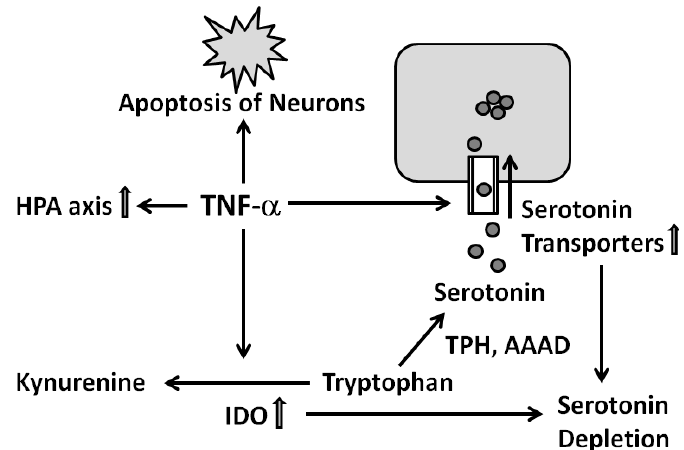
Figure 5. Mechanisms through which TNF- α could contribute to the emergence of a depression: activation of the hypothalamus-pituitary-adrenal (HPA) axis, induction of apoptosis, stimulation of the serotonin reuptake and induction of the IDO. For details see text. Abbreviations: tryptophan hydroxylase (TPH), aromatic L -amino acid decarboxylase (AAAD), indoleamine (2,3-)dioxygenase (IDO), tumor necrosis factor- α (TNF- α ).